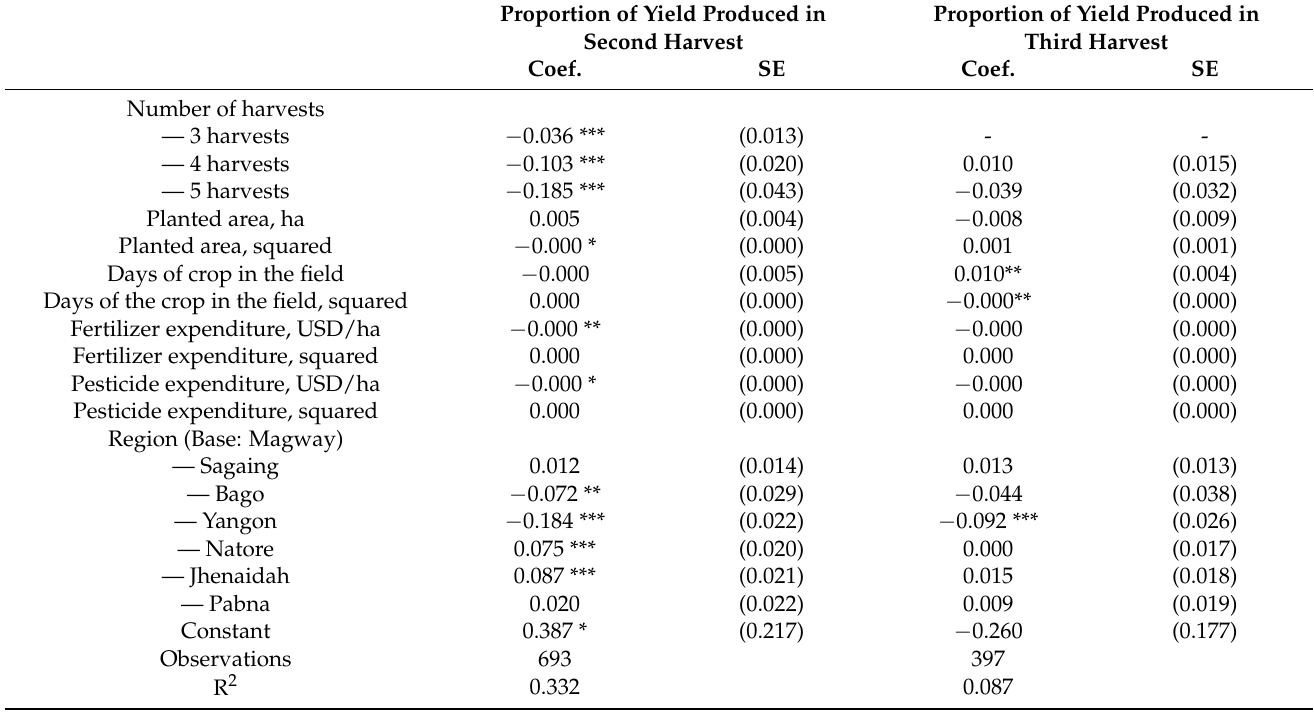
Table A3. Association between frequency of harvests and the share of the second and third harvest in total